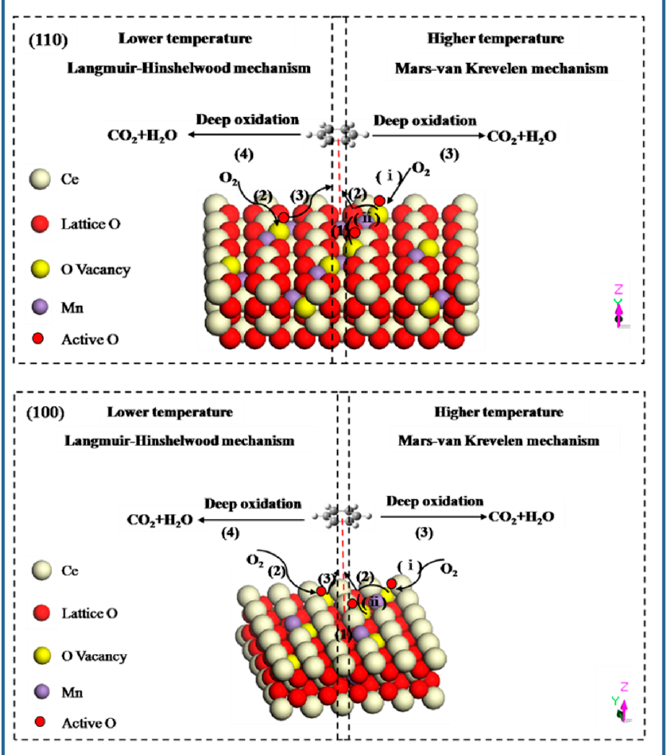
Figure 10. Proposed mechanism for benzene oxidation over Mn-doped CeO 2 on the different crystal plane.